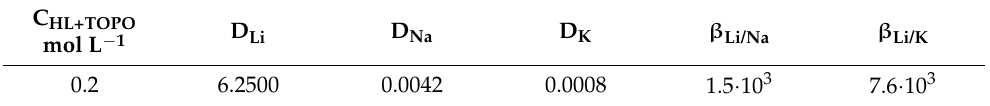
Table 2. Composition of the model solution (concentration ions g/L).